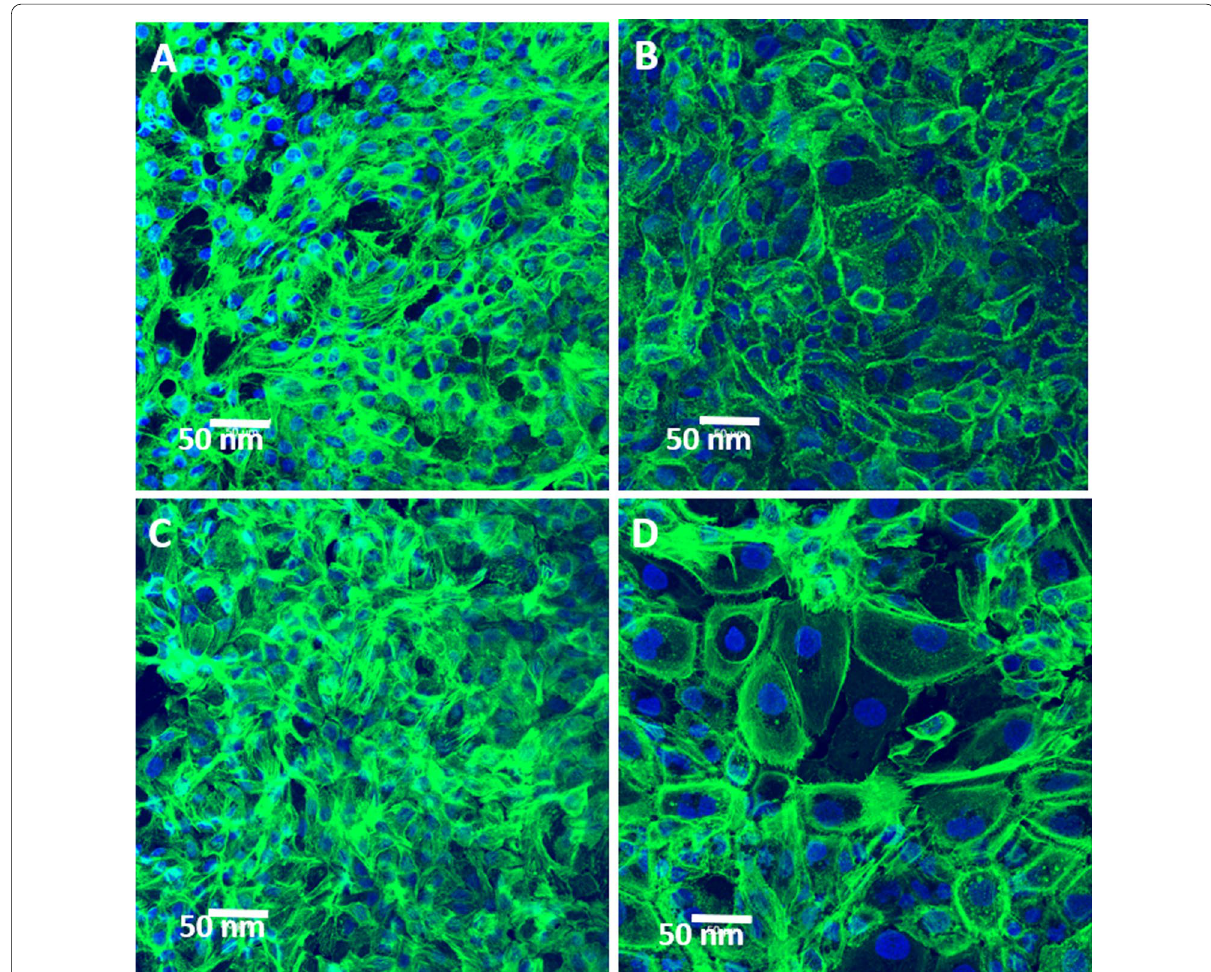
Fig. 5 Cell fluorescence images of LSCM for labeled cytoskeletons, 48 h after the irradiation of Cs‑137 with a dose of 6 Gy (magnification: and B are the images of the controls without and with irradiation of Cs‑137, respectively. C and D the images of the GNPs‑uptake cells without and with irradiation, respectively. Kit for cytoskeletons: Alexa Fluor ™ 488 Phalloidin (green). Kit for nuclei: Hoechest 33,342